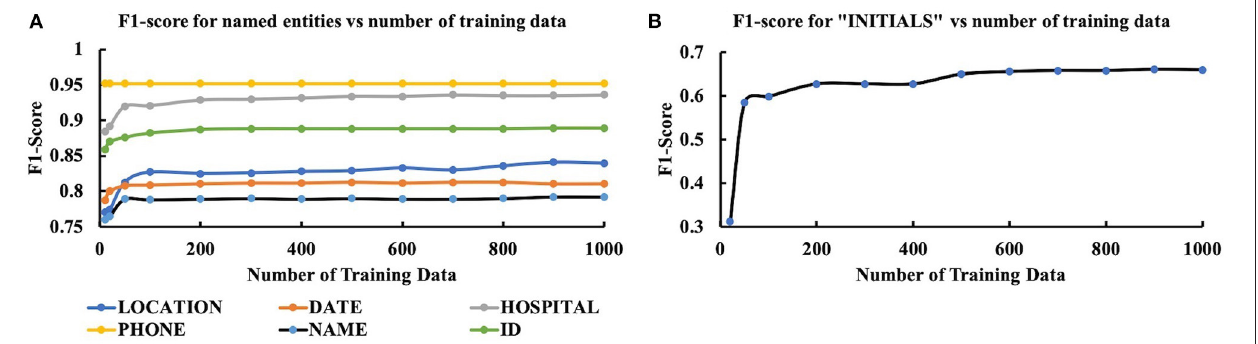
Frontiers in Digital Health |